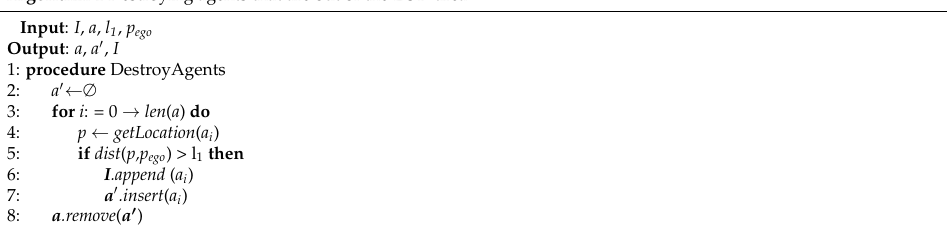
Algorithm 1 Destroying agents that are out of the LOD